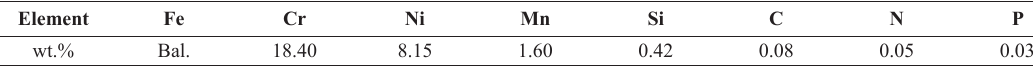
Table 1. Chemical composition of 304 SS sheets. Element